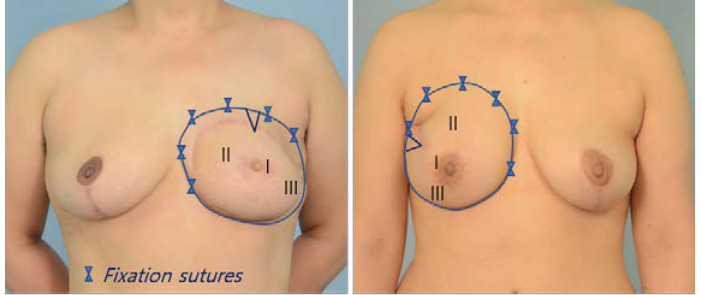
Figure 7. Breast shaping. Since the length of the pedicle is sufficient, the flap can be properly rotated according to the shape of the breast on the opposite side to create symmetry. The part marked with a V is the previous location of the belly button. Zone 2 is located in the medial and upper medial area of the horizontal breast ( Left ) and the upper and upper medial area of the longitudinal breast ( Right ); I, Zone 1; II, Zone 2; III, Zone 3.